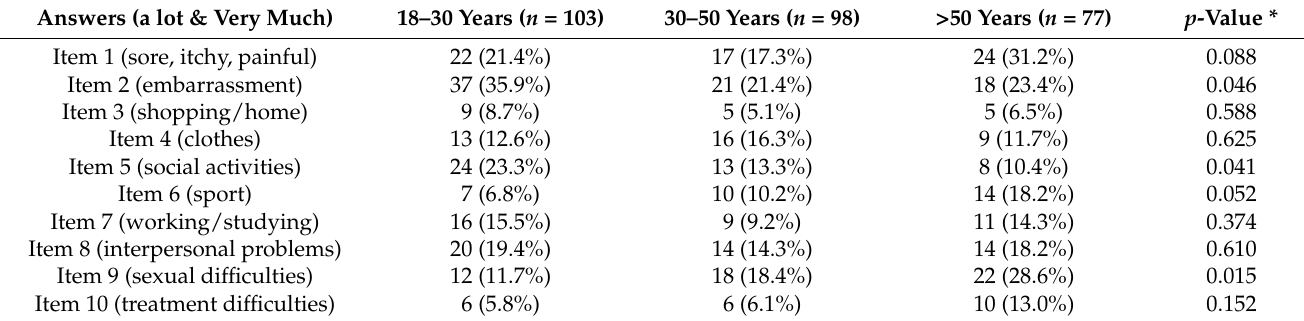
Table 5. Comparison of Dermatology Life Quality Index (DLQI) results stratified by age group.